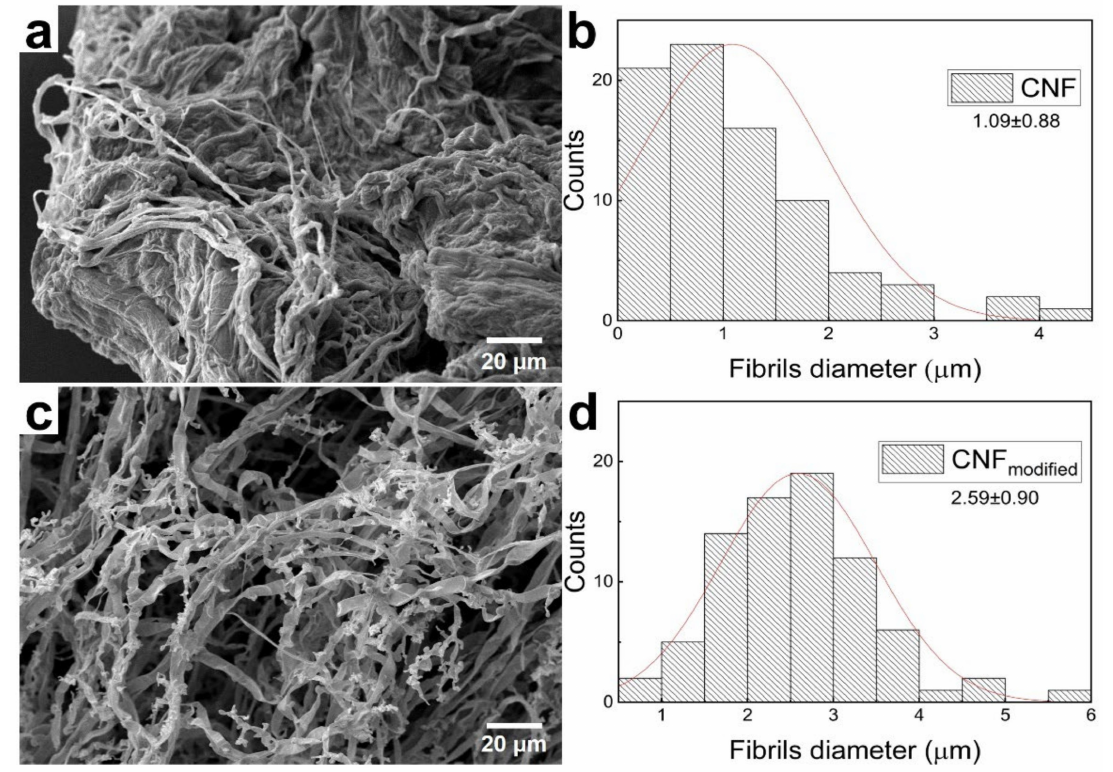
Figure 2. Biotransformation of CNF: pristine CNF ( a ), fibril diameter size distribution ( b ), 5 days of mycelium cultivation ( c ), and fibril diameter size distribution ( d